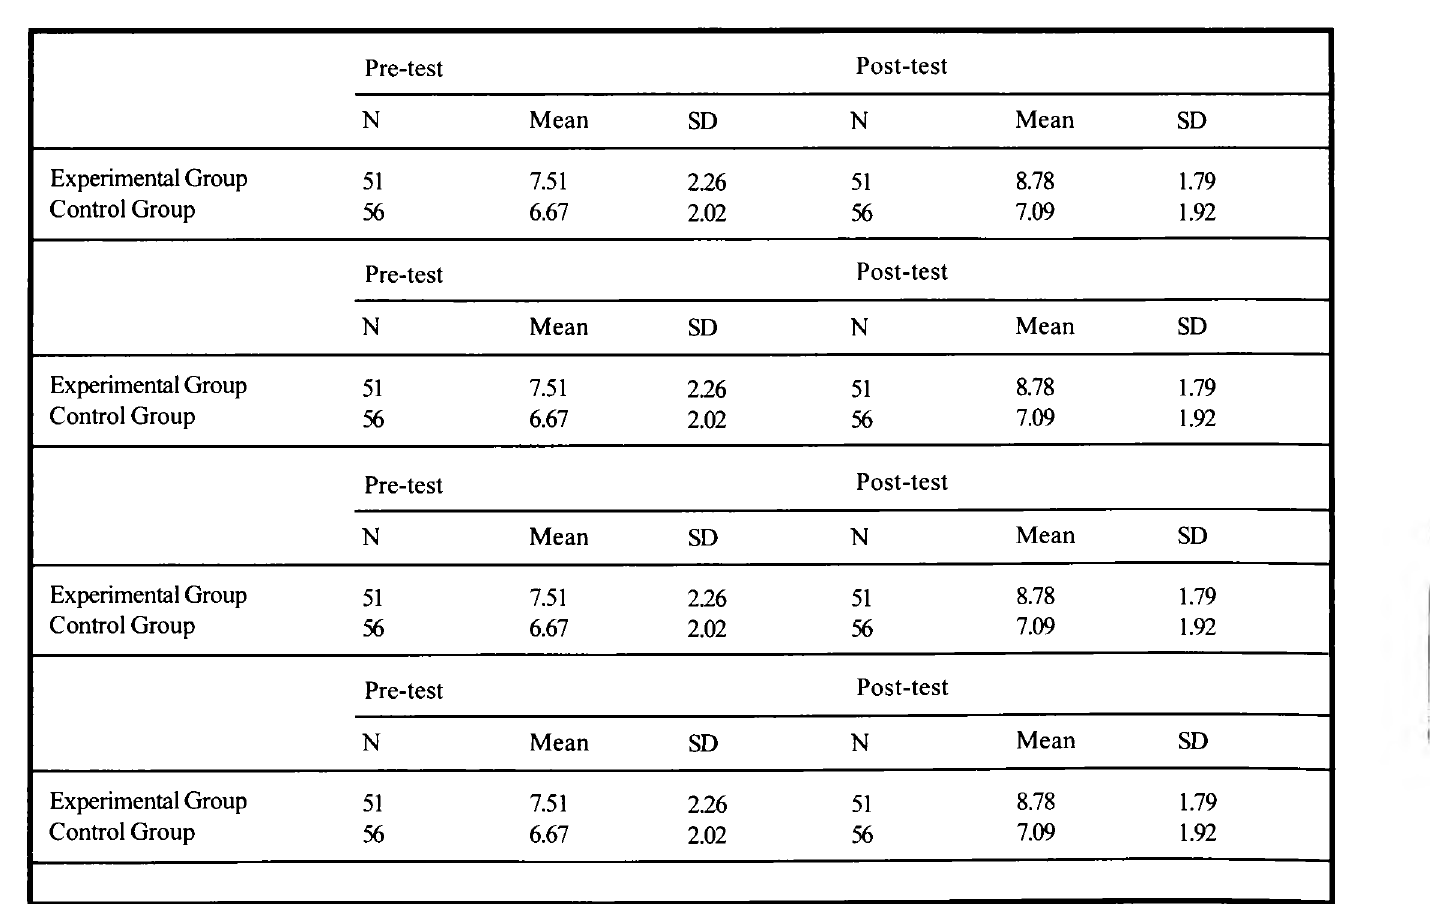
Table 2: Pre-test and post-test change in